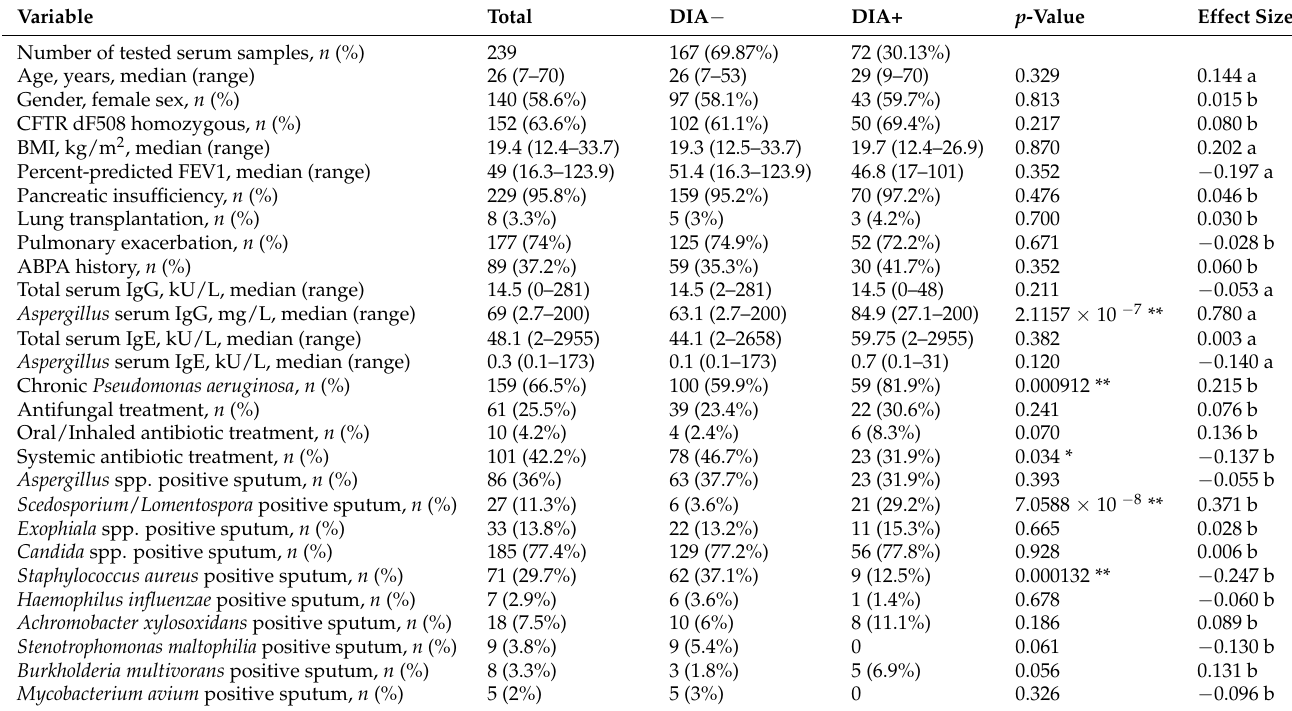
Table 3. Baseline clinical characteristics of patients’ samples. Total samples, negative (DIA-) and positive (DIA+) samples for the rapid